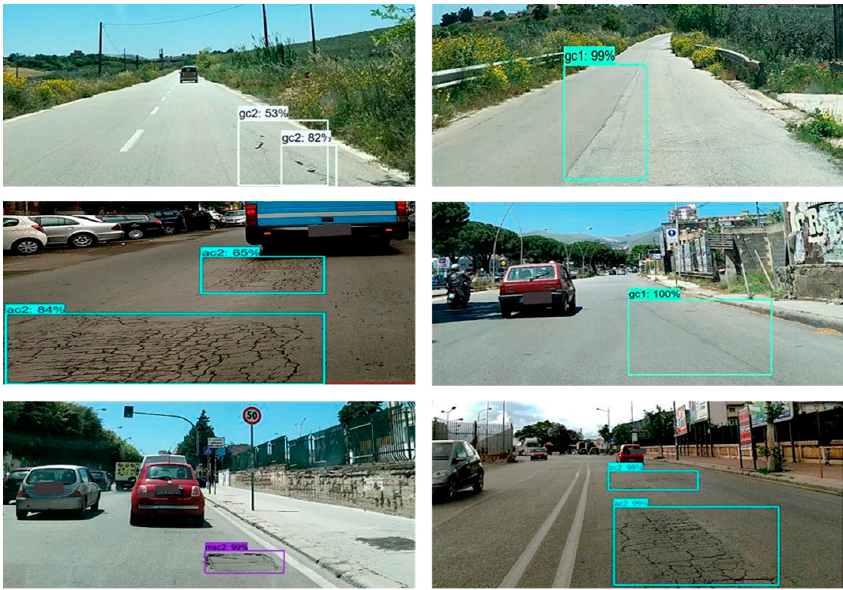
Appl. Sci. 2020 , 10 , x FOR PEER REVIEW Figure 14. SSD with Inceptionv2 model predictions on test data. Figure 14. SSD with Inceptionv2 model predictions on test data.